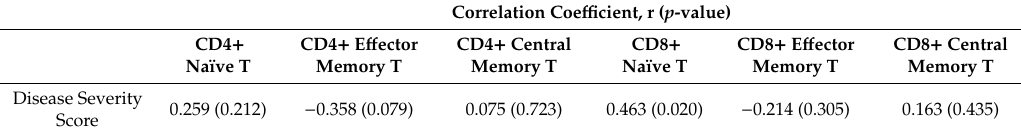
Table 5. Correlations between the frequencies of memory T cells and disease severity